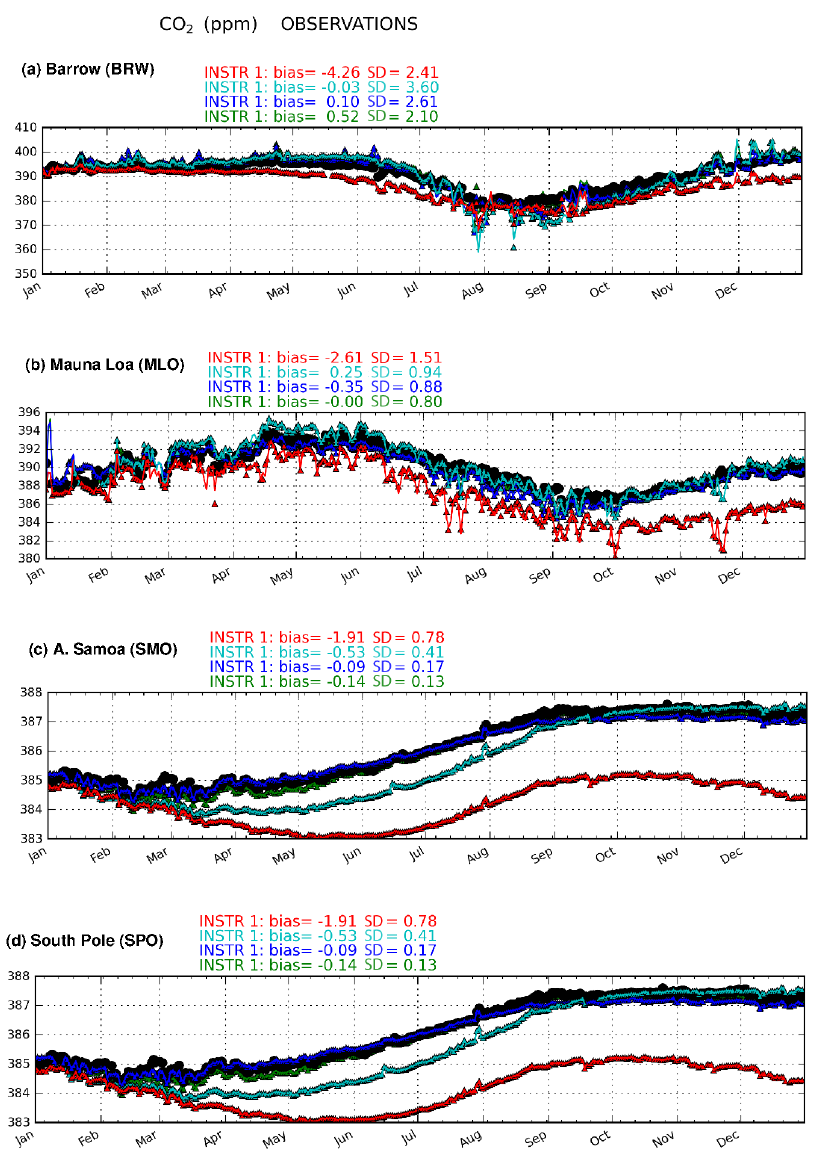
Figure 9. Daily mean atmospheric CO 2 dry molar fraction (ppm) from NOAA/ESRL continuous baseline stations (black circles) at (a) Bar- row, Alaska, USA (71.32 ◦ N, 156.61 ◦ W), (b) Mauna Loa, Hawaii, US (19.54 ◦ N, 155.58 ◦ W), (c) Tutuila, American Samoa, USA (14.25 ◦ S, 170.56 ◦ W), (d) South Pole, Antarctica (89.98 ◦ S, 24.8 ◦ W) and the different forecast experiments: BFAS (cyan), CTRL (red), OPT (green) and OPT-CLIM (blue). See Table 2 for a description of the different experiments. The mean (bias) and standard deviation (SD) of the model errors are shown at the top of each